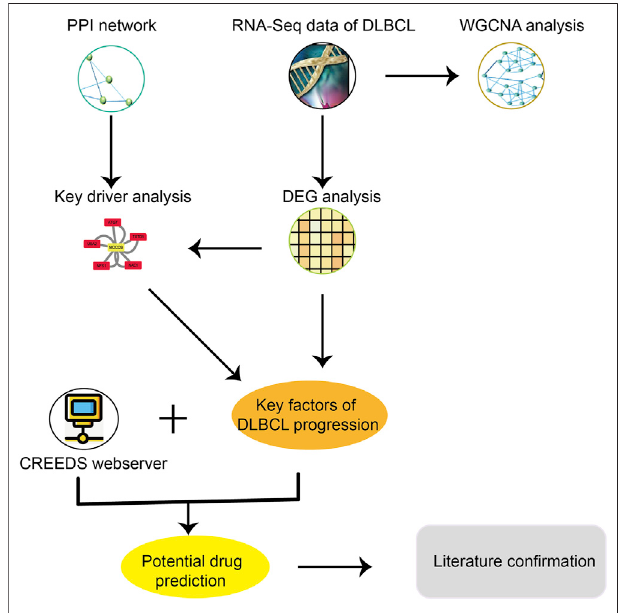
FIGURE 1 | A brief study design for drug repurposing, including these major steps: 1) Download and organize the RNA-seq data and clinical information of DLBCL from TCGA; 2) Got key factors of DLBCL progression through DEG analysis, key driver analysis and WGCNA analysis; 3) Potential drug prediction through CREEDs; 4) Literature con fi